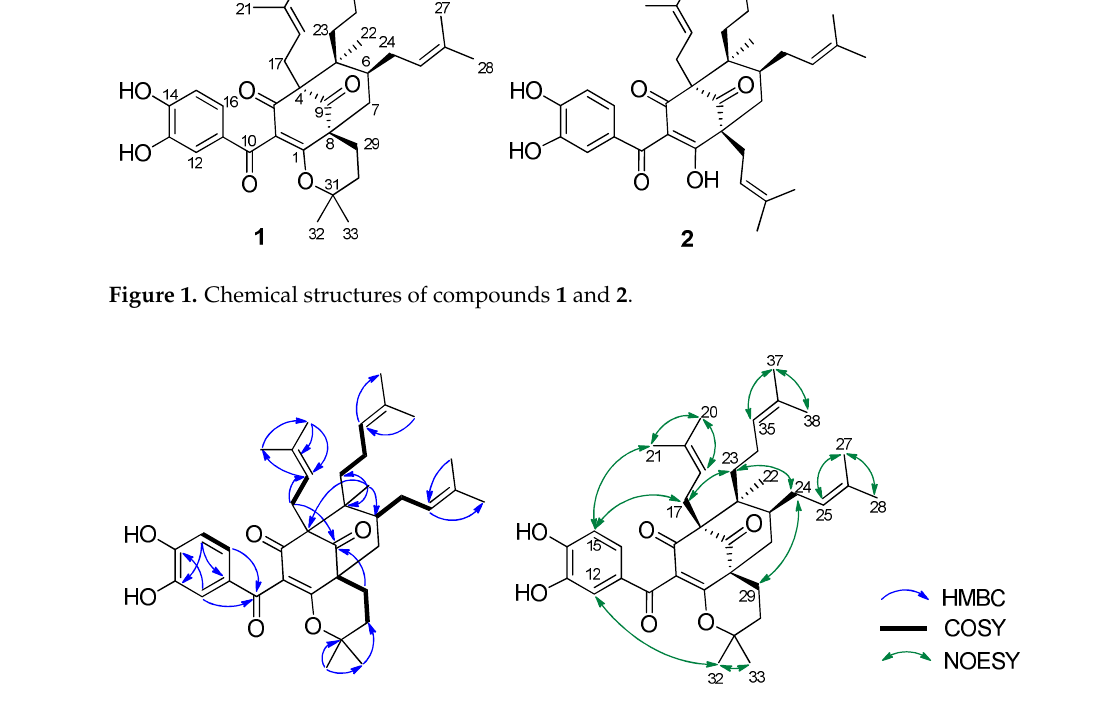
Figure 2. Key COSY, HMBC, and NOESY correlations of compound 1